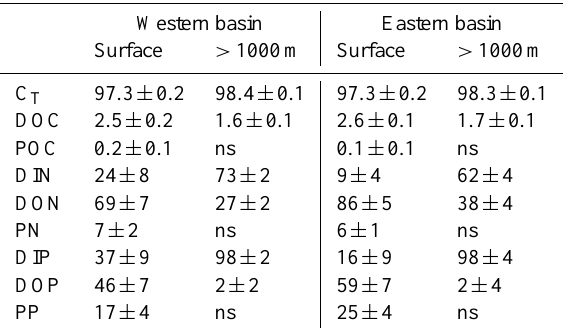
Table 2. Proportion (%) in C, N, P in the various compartments, in- organic, dissolved organic and particulate for the upper mixed layer (UML) and below 1000m, in the western and eastern basins. ns means weak contribution of POM in deep